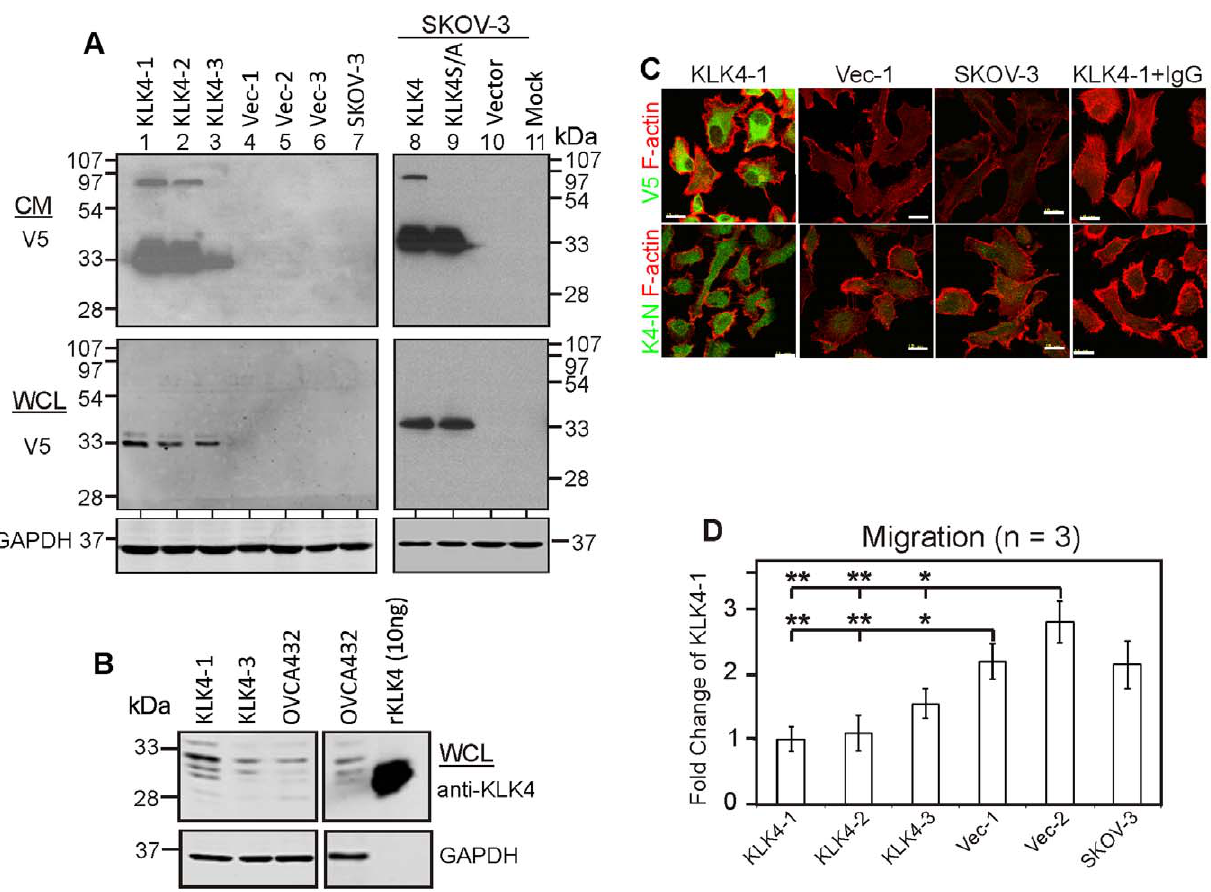
Figure 1. KLK4-expressing SKOV-3 cells are less migratory as 2D monolayers. A. Western blotting with anti-V5 antibody shows KLK4 expression in the conditioned media (CM) and whole cell lysate (WCL) from stable KLK4 tranfectants (KLK4-1, KLK4-2 and KLK-3; lanes 1–3), vector (Vec-1, Vec-2 and Vec-3; lanes 4–6) and native SKOV-3 (lane 7) cells, and transiently expressed wildtype KLK4, mutant-KLK4S207A (KLK4S/A), vector and mock transfectants (lanes 8–11); GAPDH was used as a loading control for WCL. B. Western blotting with anti-KLK4 antibody shows relative levels of KLK4 protein in WCL of KLK4-1, KLK4-3 clones and OVCA432, and 10 ng of recombinant (r)KLK4 protein. C. IF microscopy with anti-V5/KLK4-N terminal antibodies (green) and phalloidin (red) in KLK4-1, Vec-1 clones, native SKOV-3 or negative control (IgG). Scale bar, 20 m m. D. Transwell migration assays with KLK4-1, KLK4-2, KLK4-3, Vec-1, Vec-2 and native SKOV-3 cells; n=3, mean 6 SEM, *P , 0.05.